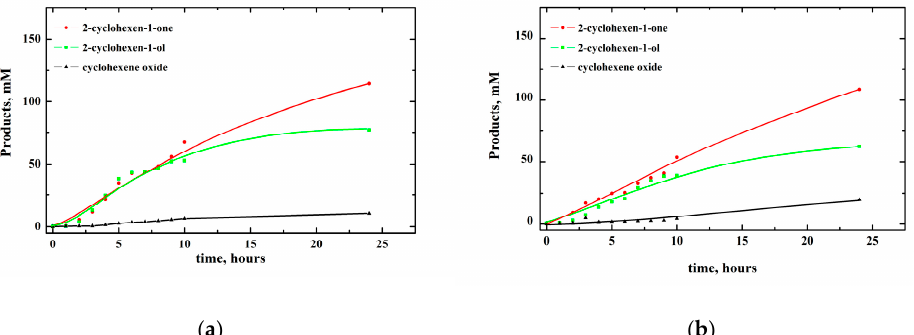
Figure 1. Dependence of products concentrations on time for oxidation of 1 M cyclohexene with ( a ) dioxygen (p O2 = 1 atm) and ( b ) air (p O2 = 0.2 atm) catalyzed by 1mM [(N4Py)Fe II ] 2+ in MeCN.